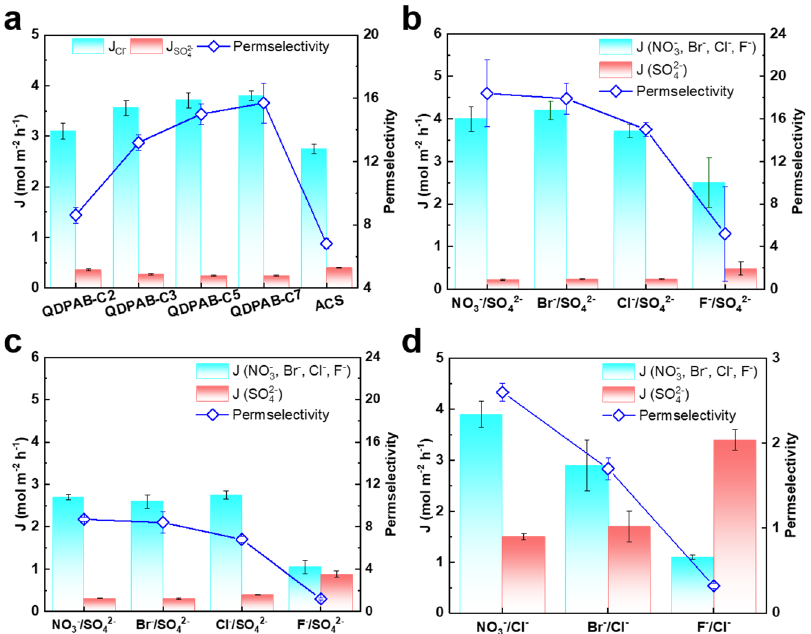
Figure 4. ( a ) Anion flux and permselectivity of the QDPAB-Cx and ACS membranes in a 0.1 mol L − 1 NaCl/0.1 mol L − 1 Na 2 SO 4 mixed solution at a current density of 10 mA cm − 2 ; ( b ) anion flux and permselectivity of the QDPAB-C5 membrane in different mixed solutions consisting of vari- ous monovalent anions and SO 42 − ions (0.1 mol L − 1 NaNO 3 /0.1 mol L − 1 Na 2 SO 4 , 0.1 mol L − 1 NaBr/0.1 mol L − 1 Na 2 SO 4 , 0.1 mol L − 1 NaCl/0.1 mol L − 1 Na 2 SO 4 , and 0.1 mol L − 1 NaF/0.1